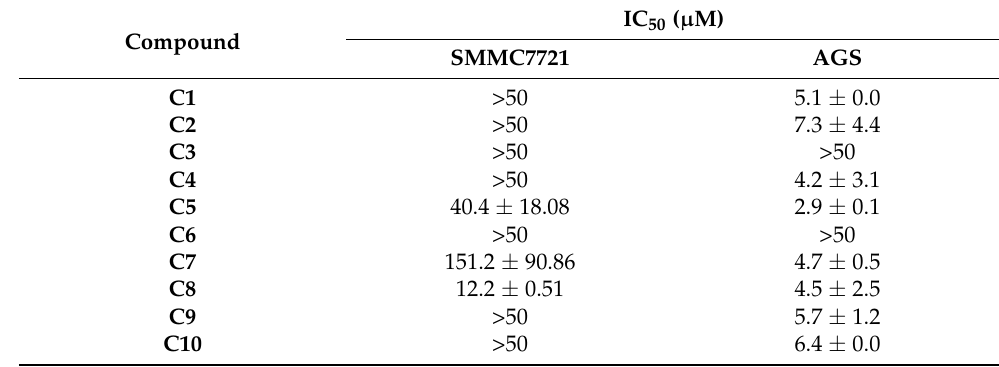
Table 4. Antiproliferative activities (IC 50 , µ M) of compounds C1–C10 on SMMC7721 and AGS cells for 48 h.